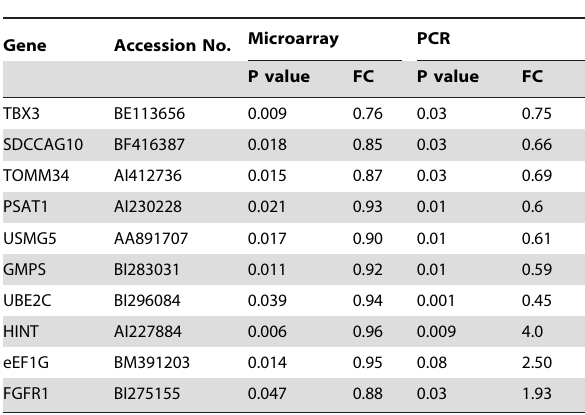
Table 3. Microarray and Real-time PCR determination of gene targets in whole embryonic tissue exposed to a maternal iron deficient diet, relative to a control iron diet (FC =Fold change); n= 8.